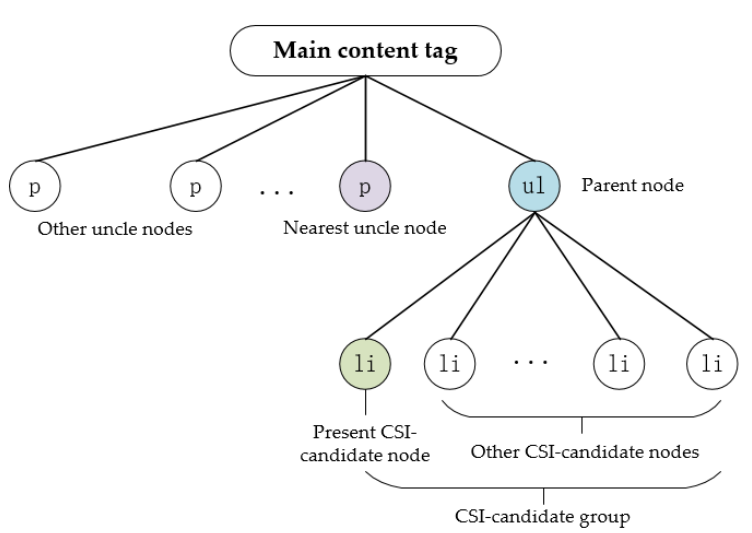
Figure 8. Relationship between nodes in HTML structure.